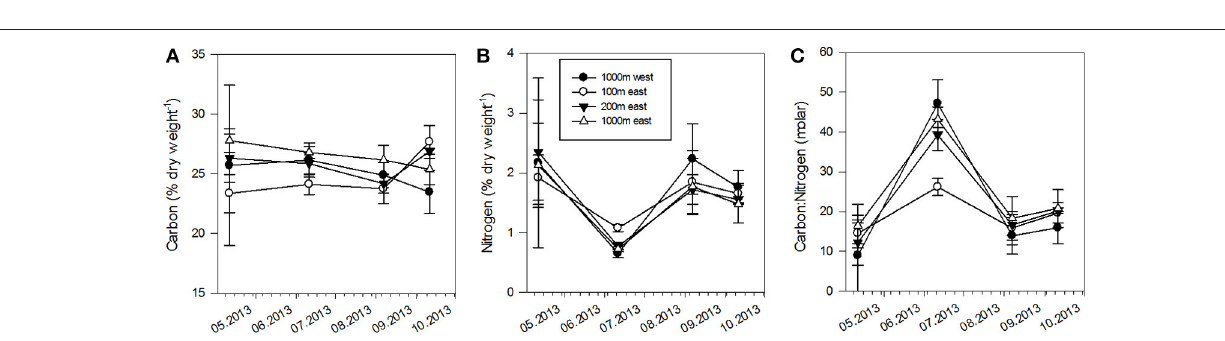
FIGURE 9 | Seasonal percentage of (A) nitrogen, (B) carbon of dry weight, and (C) C:N ratio of kelp tissues at 5m depth at the four experimental stations (mean, n =